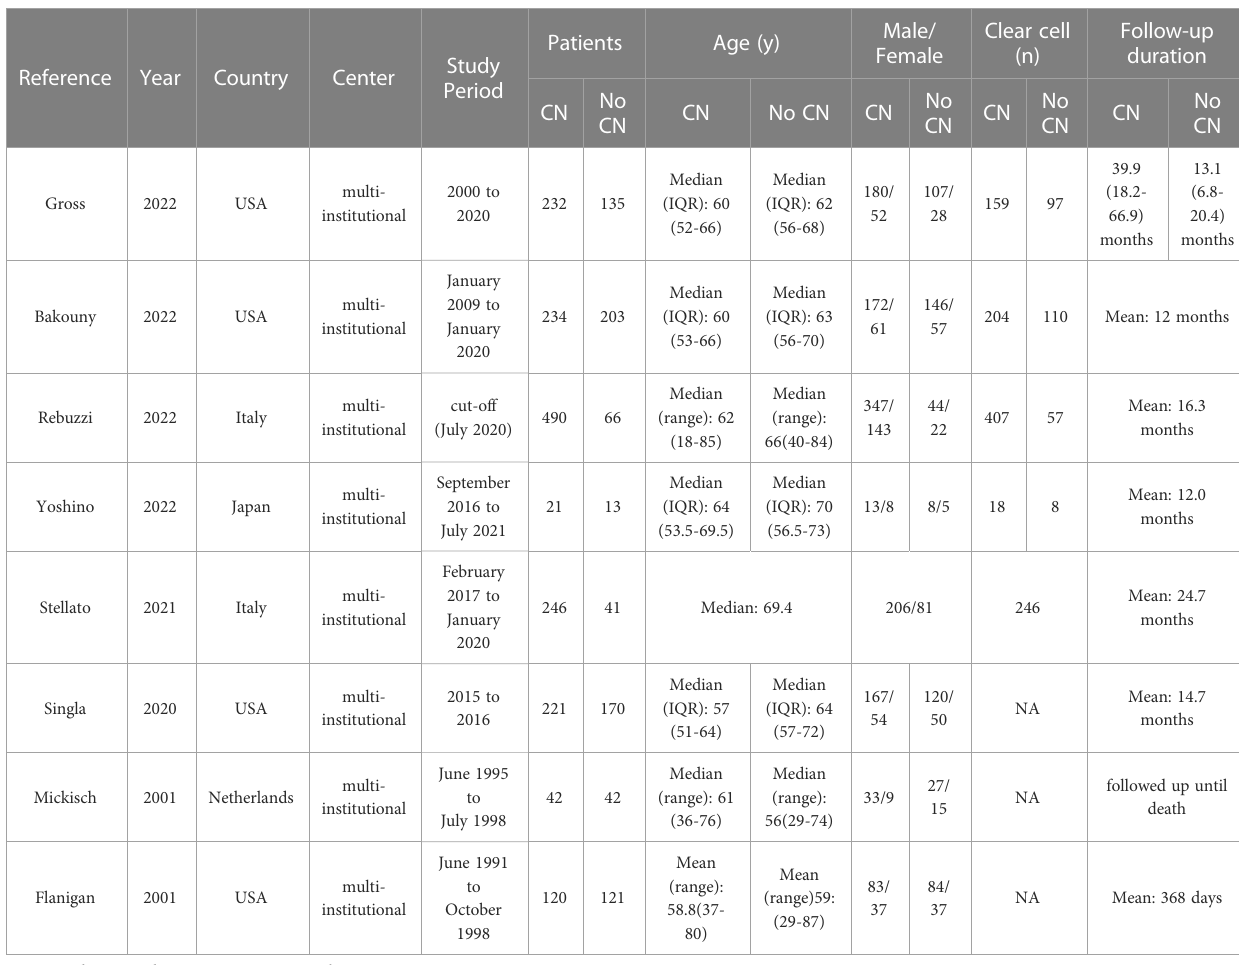
TABLE 1 The trials included in the systemic